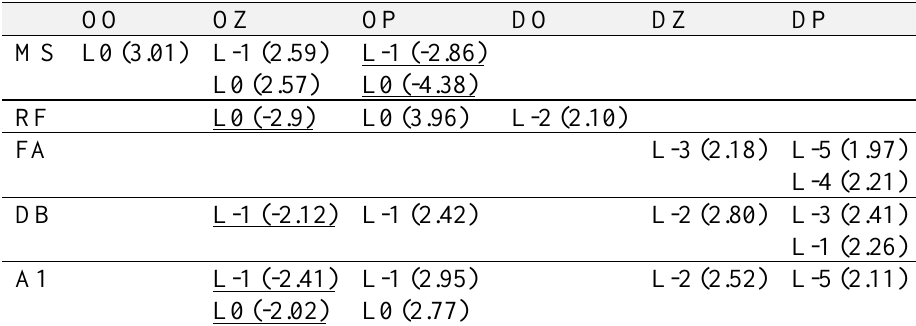
Table 3. Lag sequential analysis between the given categories of the Consequence of completion dimension and the target behaviours corresponding to the Zone dimension. In the left column are the given behaviours